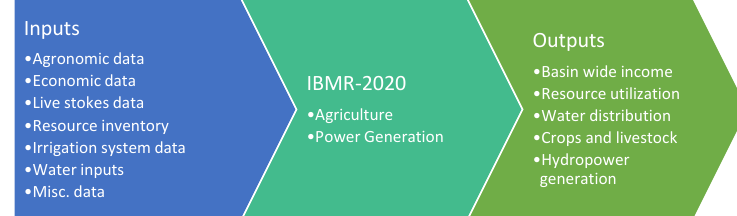
Figure 2. Conceptual model of